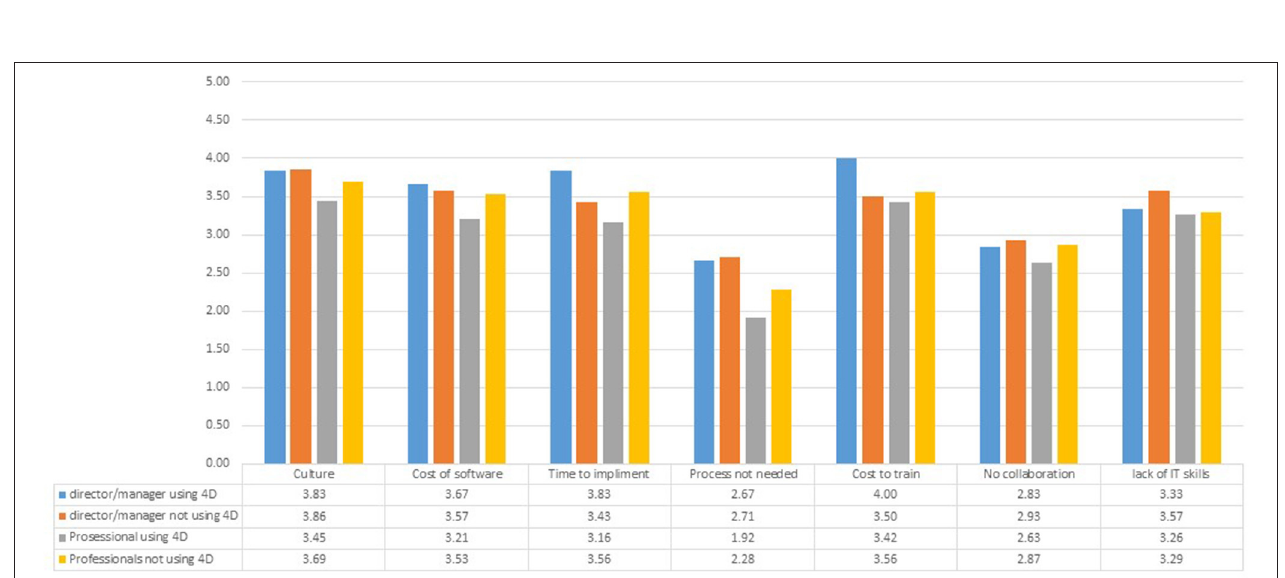
FIGURE 3 | Barriers to 4D Adoption for construction site health and